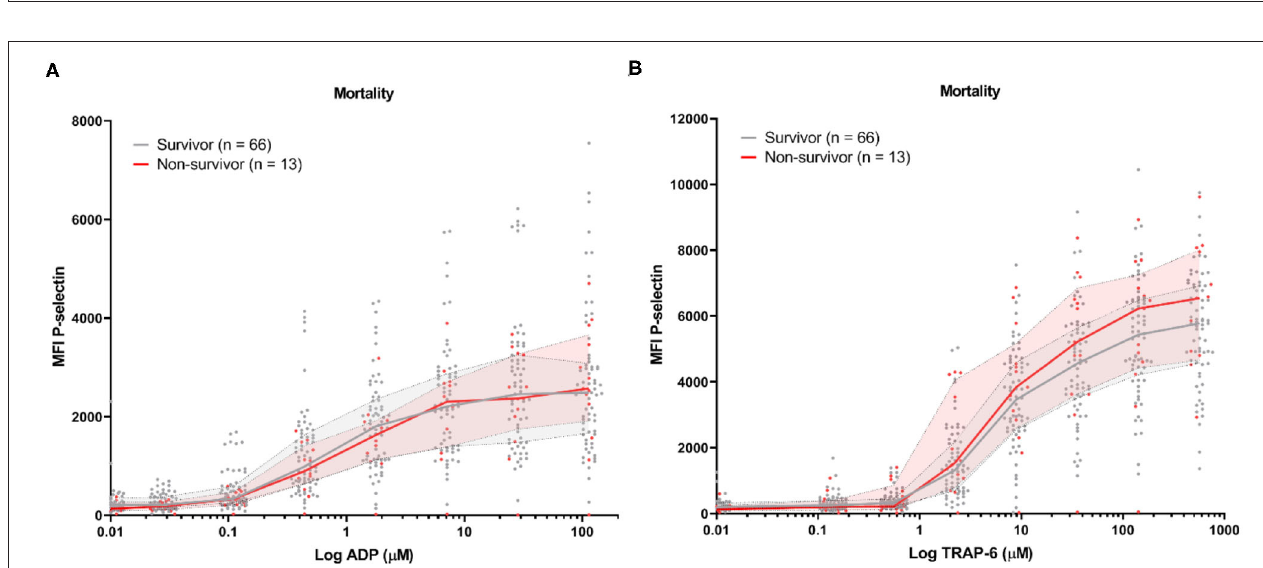
FIGURE 2 | COVID-19 patient platelet reactivity stratified by all-cause mortality. Median fluorescence intensity (MFI) of platelet P-selectin expression in response to ADP (A) , or TRAP-6 (B) . Data points represent individual values of non-survivors ( n = 13; displayed in red) or survivors ( n = 66; displayed in gray). The median value and interquartile range are indicated. Statistical difference was tested for all concentrations of agonist using one-way ANOVA with Sidak’s multiple comparisons test. No significant differences were